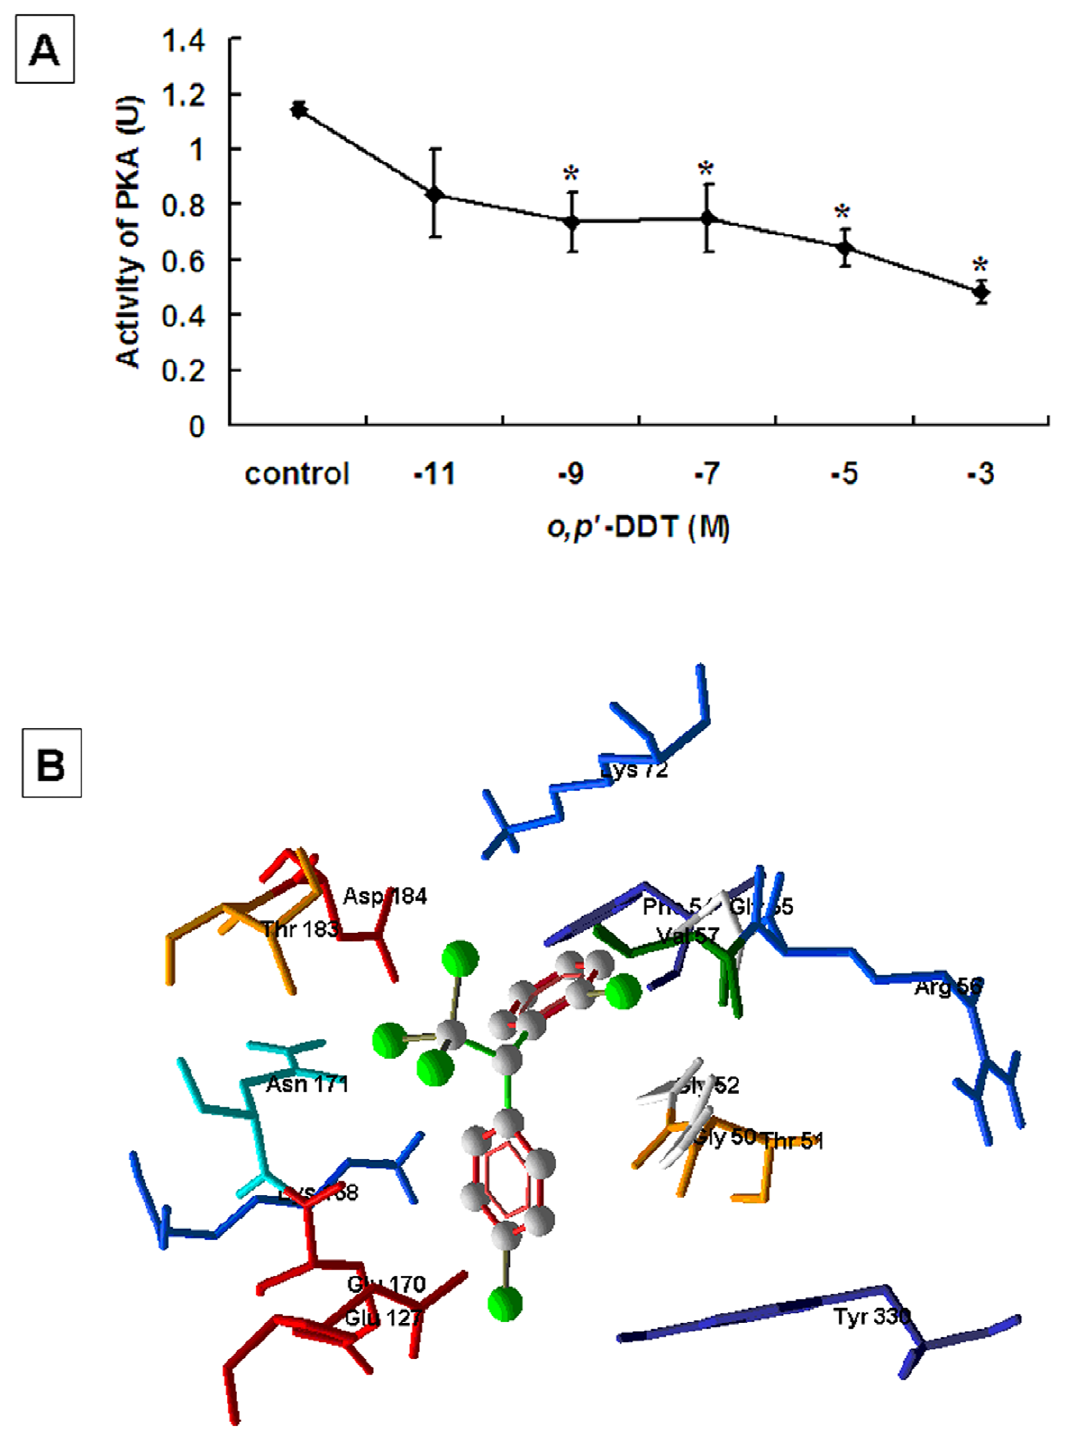
Figure 6. Direct inhibition of PKA activity by o,p’ -DDT. ( A ) o,p’ -DDT at concentration of 10 2 11 to 10 2 3 M was incubated with 1.25 U purified active catalytic subunit of PKA (control enzyme provided in the PKA PepTag Assay kit). PKA activity was measured using PepTag Assay. The kinase activity was quantitated, as described in Materials and Methods . The results of three independent experiments performed were shown as mean 6 SEM. *, r , 0.05, compared to control. ( B ) The interaction of o,p’ -DDT with PKA. o,p’ -DDT was represented in 3D with ball and stick models and the protein was represented in stick models.